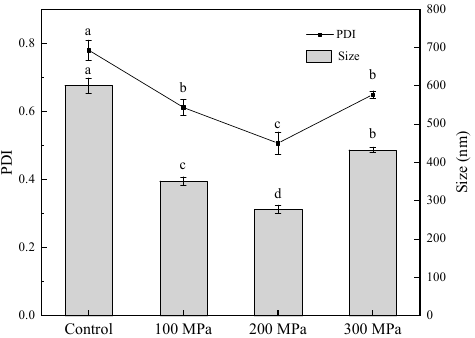
Figure 4. Effect of HHP pretreatment on the particle size and the PDI of RBPH. HHP: high hydrostatic pressure; RBPH: rice bran protein hydrolysates; PDI: polydispersity index; the particle size was characterized by the d4,3 (volume average particle size). Control, 100 MPa, 200 MPa, and 300 MPa represent RBPH samples subjected to 0, 100, 200, and 300 MPa pretreatment, respectively. Different lowercase letters indicate values that differ significantly ( p < 0.05). All the HHP pretreatments were conducted at 25 °C for 30 min.